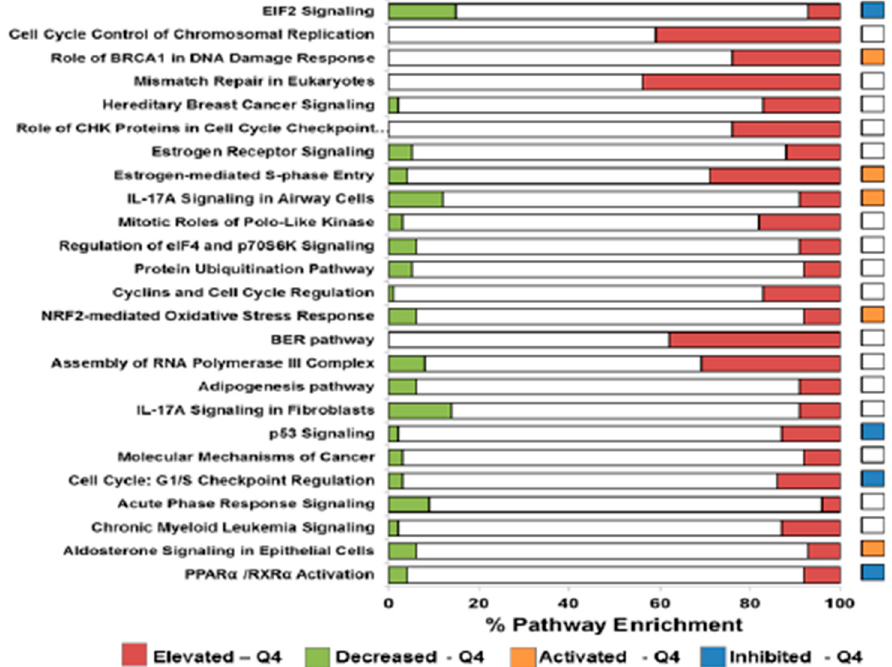
Figure 2. Pathway analyses of differentially expressed transcripts identified in endometrioid endometrial cancer (EEC) patients classified by high versus low metastatic risk. Data reflect the top twenty-five significant canonical pathways (–log p -value ≥ 2.0, Supplementary File S12) enriched among significant differentially expressed transcripts (Supplementary File S1) identified in RNA-seq data from endometrioid endometrial cancer patients in the Training-1 cohort classified by high (Q4, n = 19) versus low (Q1, n = 19) metastatic risk (Supplementary Files S11–S13).